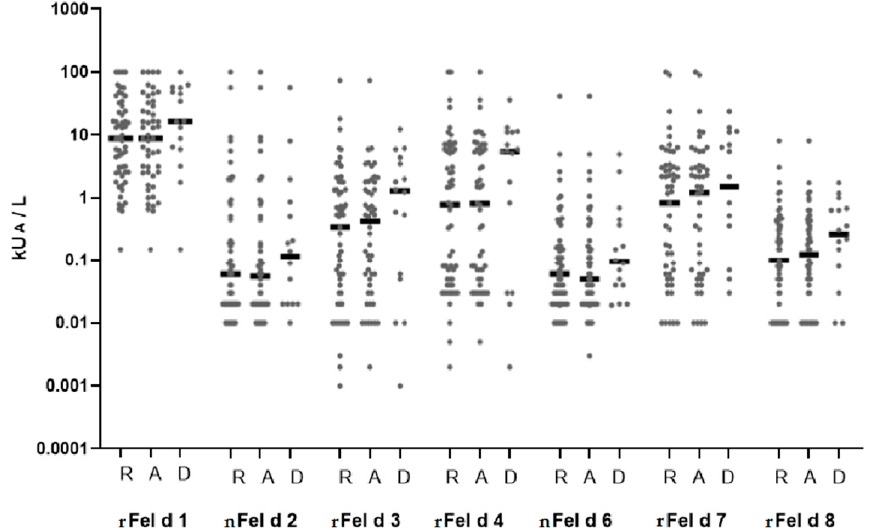
Figure 4. IgE levels ( y -axis: sensitization, measured in kU A /L; median IgE levels are indicated by horizontal bars) specific to cat allergen molecules (Fel d 1–Fel d 8) in patients with different symptoms of cat allergy (R: rhinitis; A: asthma; D: dermatitis).